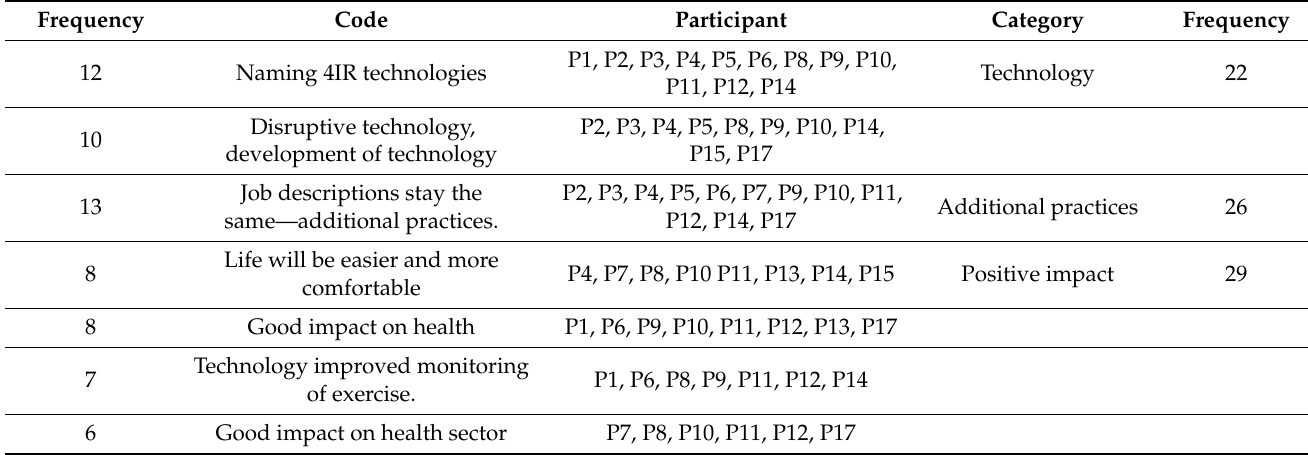
Table 1. The Comprehensibility of the Fourth Industrial Revolution (4IR) by Managers.